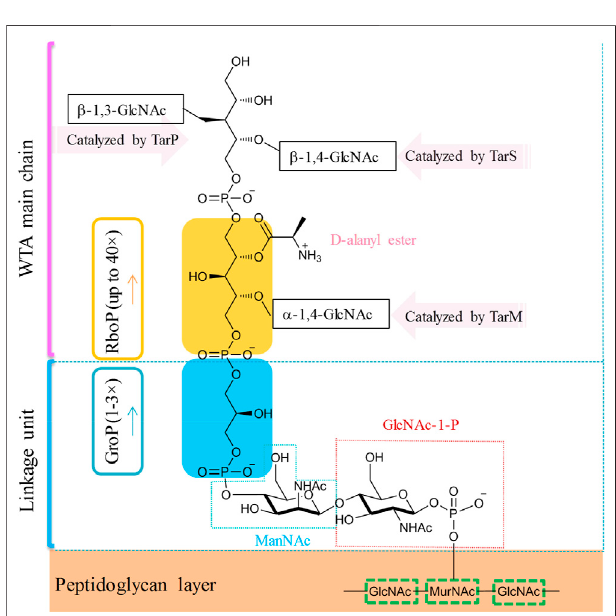
FIGURE 7 | Simpli fi ed molecular structure of the WTA of common S.